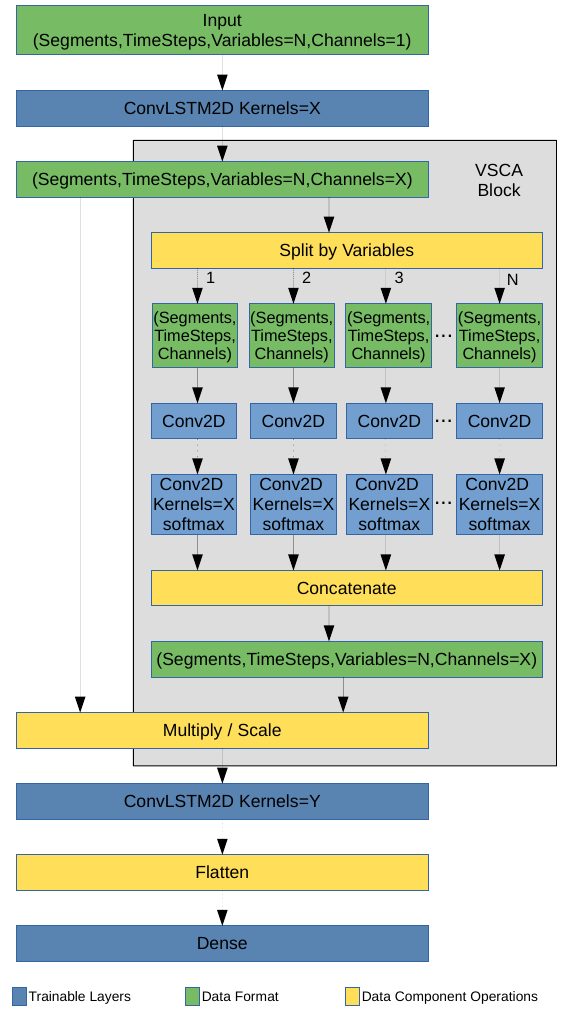
Figure 7. Variable Split Convolutional Attention model applied to the prediction